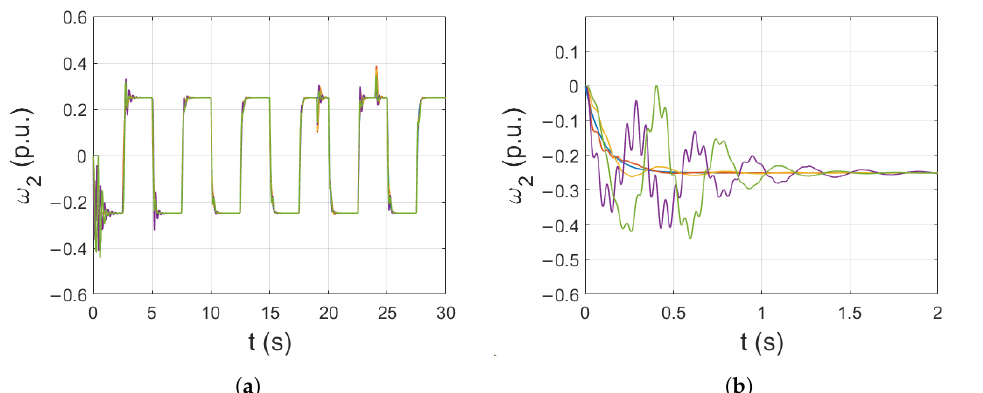
Figure 9. Effect of initial centers randomization (of radial activation functions) ( a ), close-up for the beginning of the simulation ( b ).